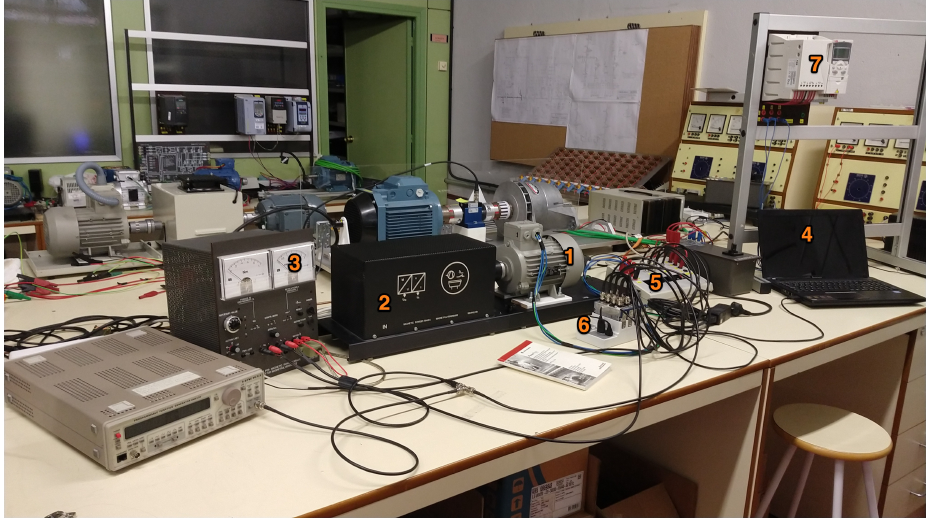
Figure 3. Elements of the test bench: ( 1 ) Induction motor; ( 2 ) Magnetic powder brake; ( 3 ) Brake control unit; ( 4 ) Laptop; ( 5 ) Custom-made board of sensors; ( 6 ) CompaqDAQ by National Instruments; ( 7 ) ABB